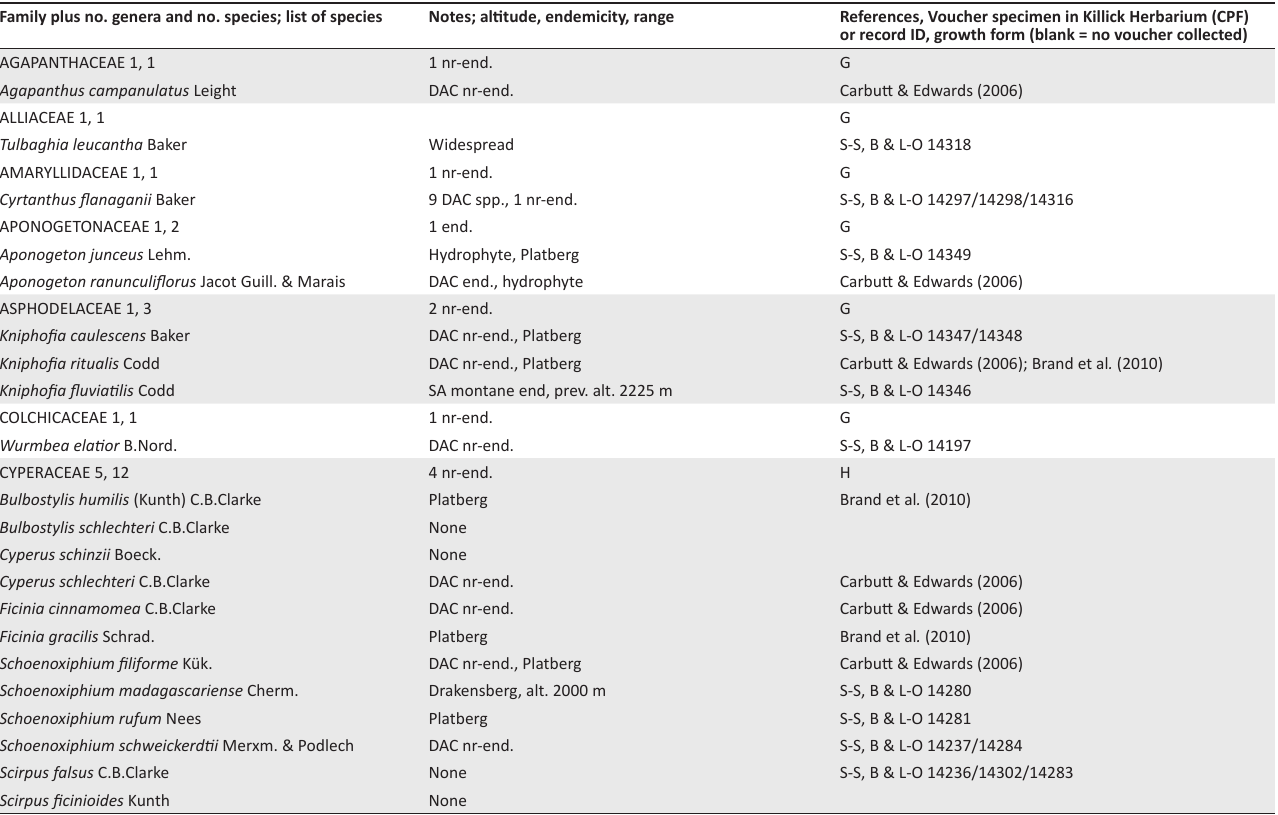
Table 2-A1 continues on the next page →